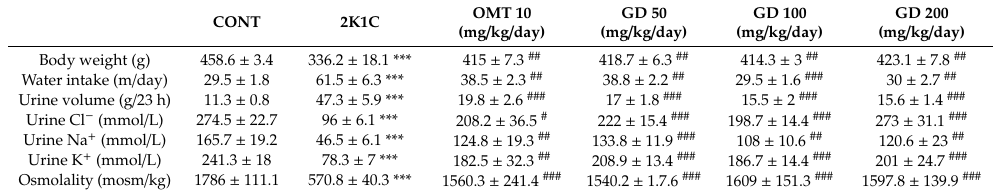
Table 3. E ff ects of the Gynura divaricata (L.) DC (GD) treatment on renal excretory function in 2K1C rats.